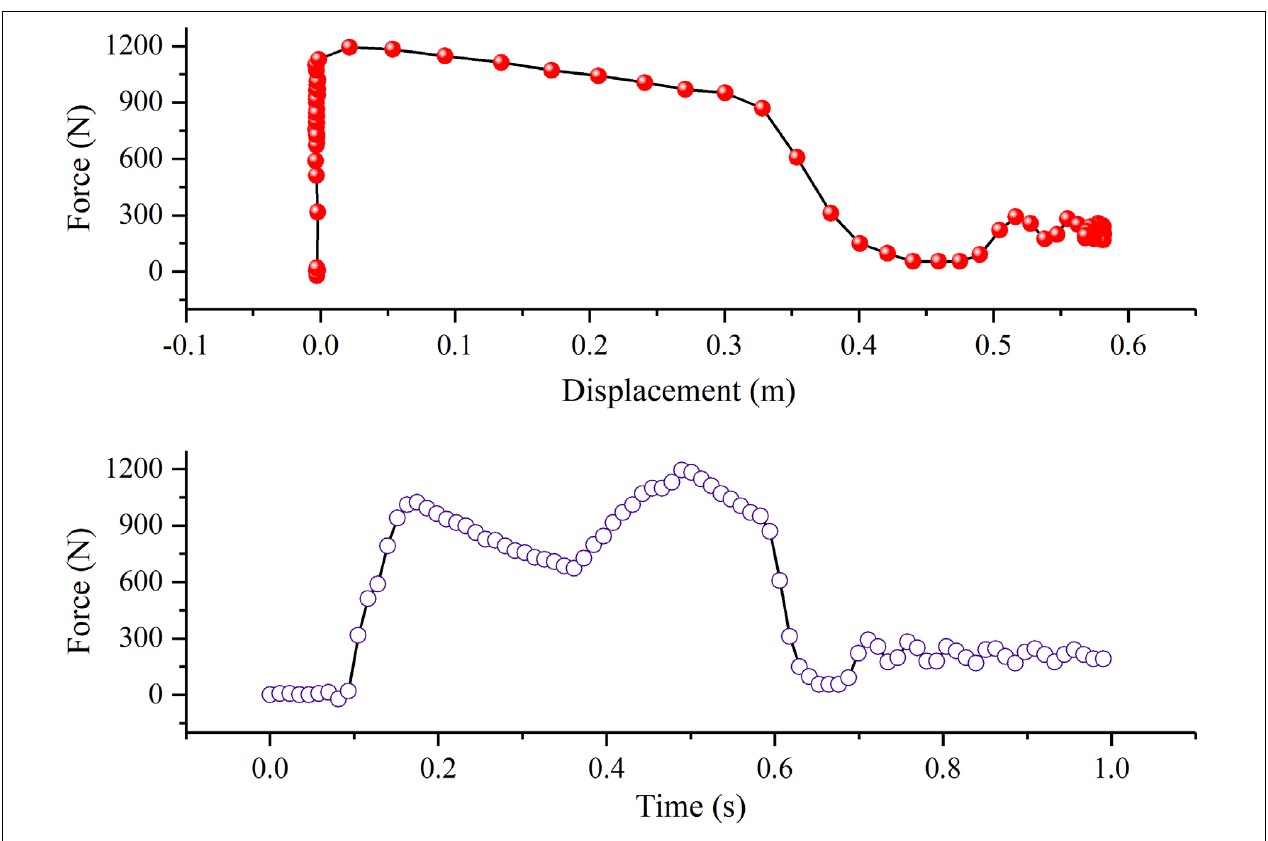
FIGURE 9 | “Platform-like effect” by the force peak shifting control ( v max = 2 m/s).